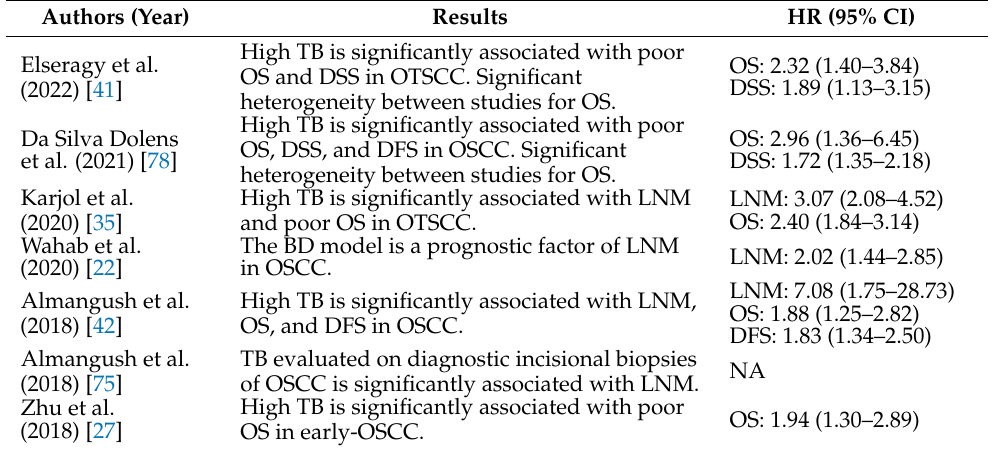
Table 3. Systematic review and meta-analysis regarding the prognostic role of Tumor Budding in Oral Squamous Cell